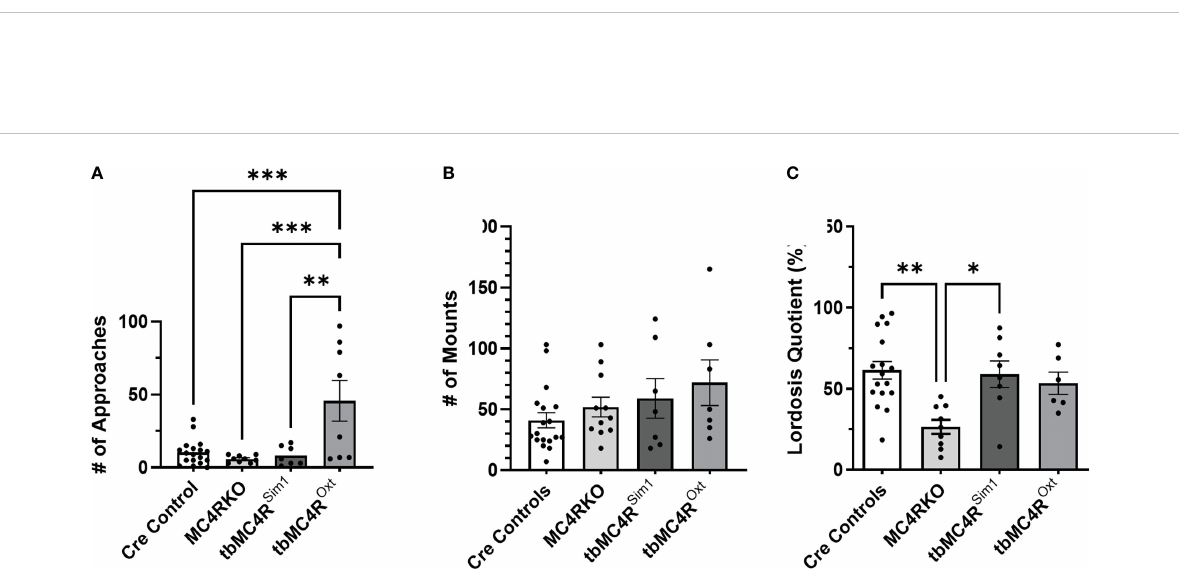
FIGURE 12 MC4R expression exclusively on Sim1 neurons resulted in a lordosis quotient comparable to the Sim1-cre control. Female approaches to the male (A) , male mounts (B) , and lordosis quotient (C) were compared between combined cre controls (n=17-18), MC4RKO (n=9-11), tbMC4R Sim1 (n=7-8), and tbMC4R Oxt mice (n=6-7). One-way ANOVA with Sidak ’ s multiple comparisons test was used for graphs A and C. Brown-Forsythe and Welch ANOVA tests with Dunnett ’ s T3 multiple comparisons test was used for graph B. Graph A, tbMC4R Oxt vs Cre Controls (p=0.0003) and MC4RKO (p=0.0003) and tbMC4R Sim1 (p=0.0017); Graph C, MC4RKO vs Cre Controls (p=0.0009) and tbMC4R Sim1 (p=0.011) and tbMC4R Oxt (p=0.069) *p<0.05; **p<0.01;